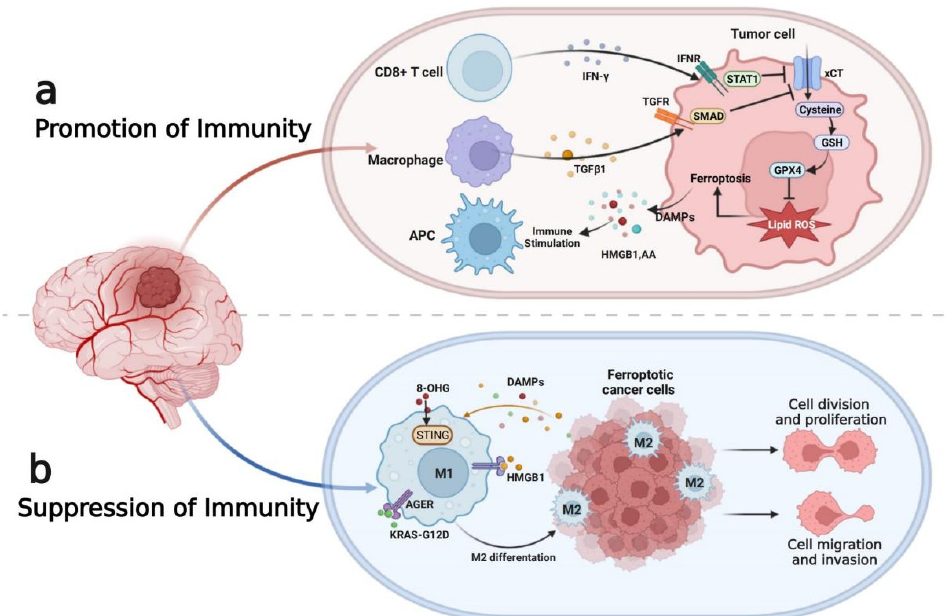
Figure 3. Role of ferroptosis in glioma immunity. ( a ) CD8 + T cells release IFN γ to activate INFR (which inhibits SLC7A11 transcription through STAT1) to promote tumour cell ferroptosis. TGF β 1 released by macrophages induces the downregulation of system xCT mediated by SMAD proteins, thereby triggering lipid ROS-mediated ferroptosis via the GSH-GPX4 axis. In turn, ferroptotic glioma cells release DAMPs (such as HMGB1 and AA) to promote the recruitment and activation of immune cells. ( b ) In contrast, DAMPs, such as HMGB1, KRAS-G12D and 8-OHG, could affect the function of macrophages in the tumour microenvironment. In particular, KRAS-G12D binds AGER on the cell surface of macrophages to trigger M2 macrophage polarization, which might limit antitumour immunity. IFN- γ , interferon- γ ; INFR, interferon receptor; STAT1, signal transducer and activator of transcription 1; GSH, glutathione; GPX4, glutathione peroxidase 4; DAMPs, damage-associated molecular patterns; HMGB1, high mobility group protein B1; AA, arachidonic acid; 8-OHG, 8-hydroxyguanosine; AGER, advanced glycosylation end productspecific receptor.